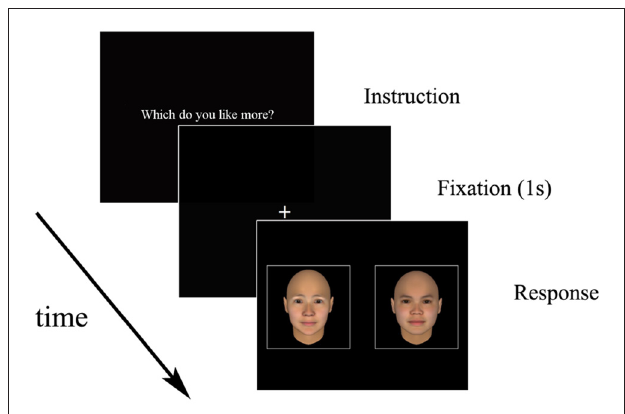
FIGURE 1 | Example of stimuli presented to participants.